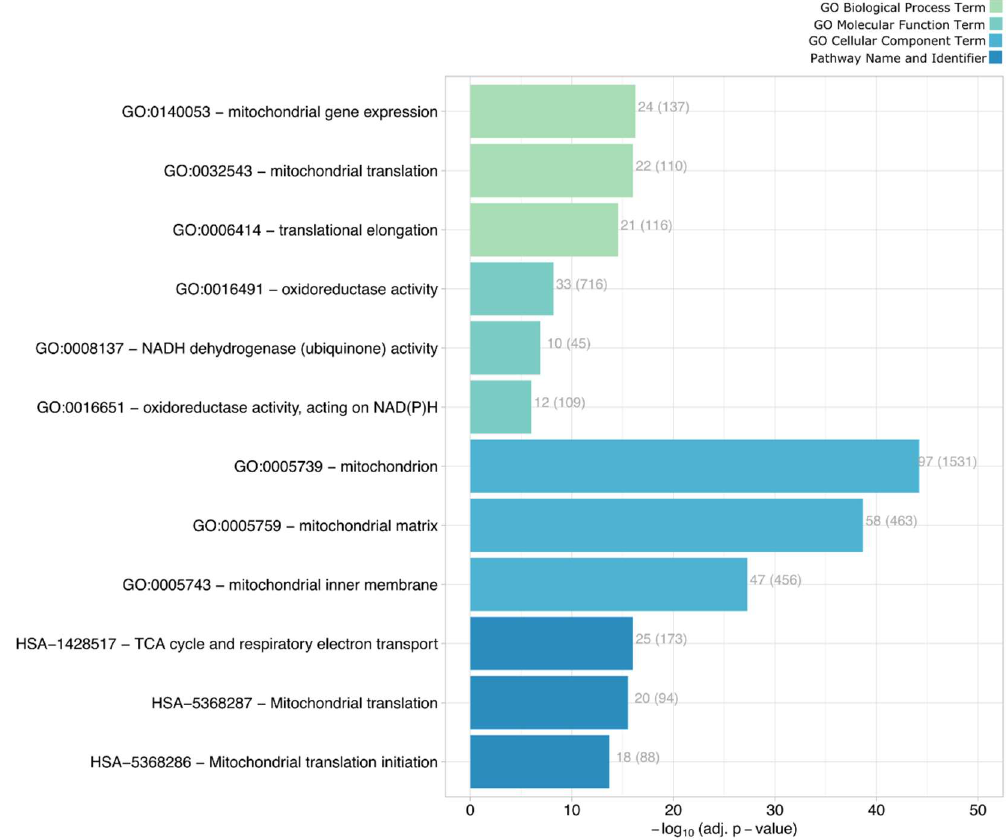
Figure 4. Most enriched processes, functions, components and pathways represented by the 231 movers. X -axis reports the corresponding negative log p-values, adjusted for multiple testings. The numbers at the end of the bars refer to the number of mapped proteins over the total number of proteins involved in the corresponding term (indicated in brackets).